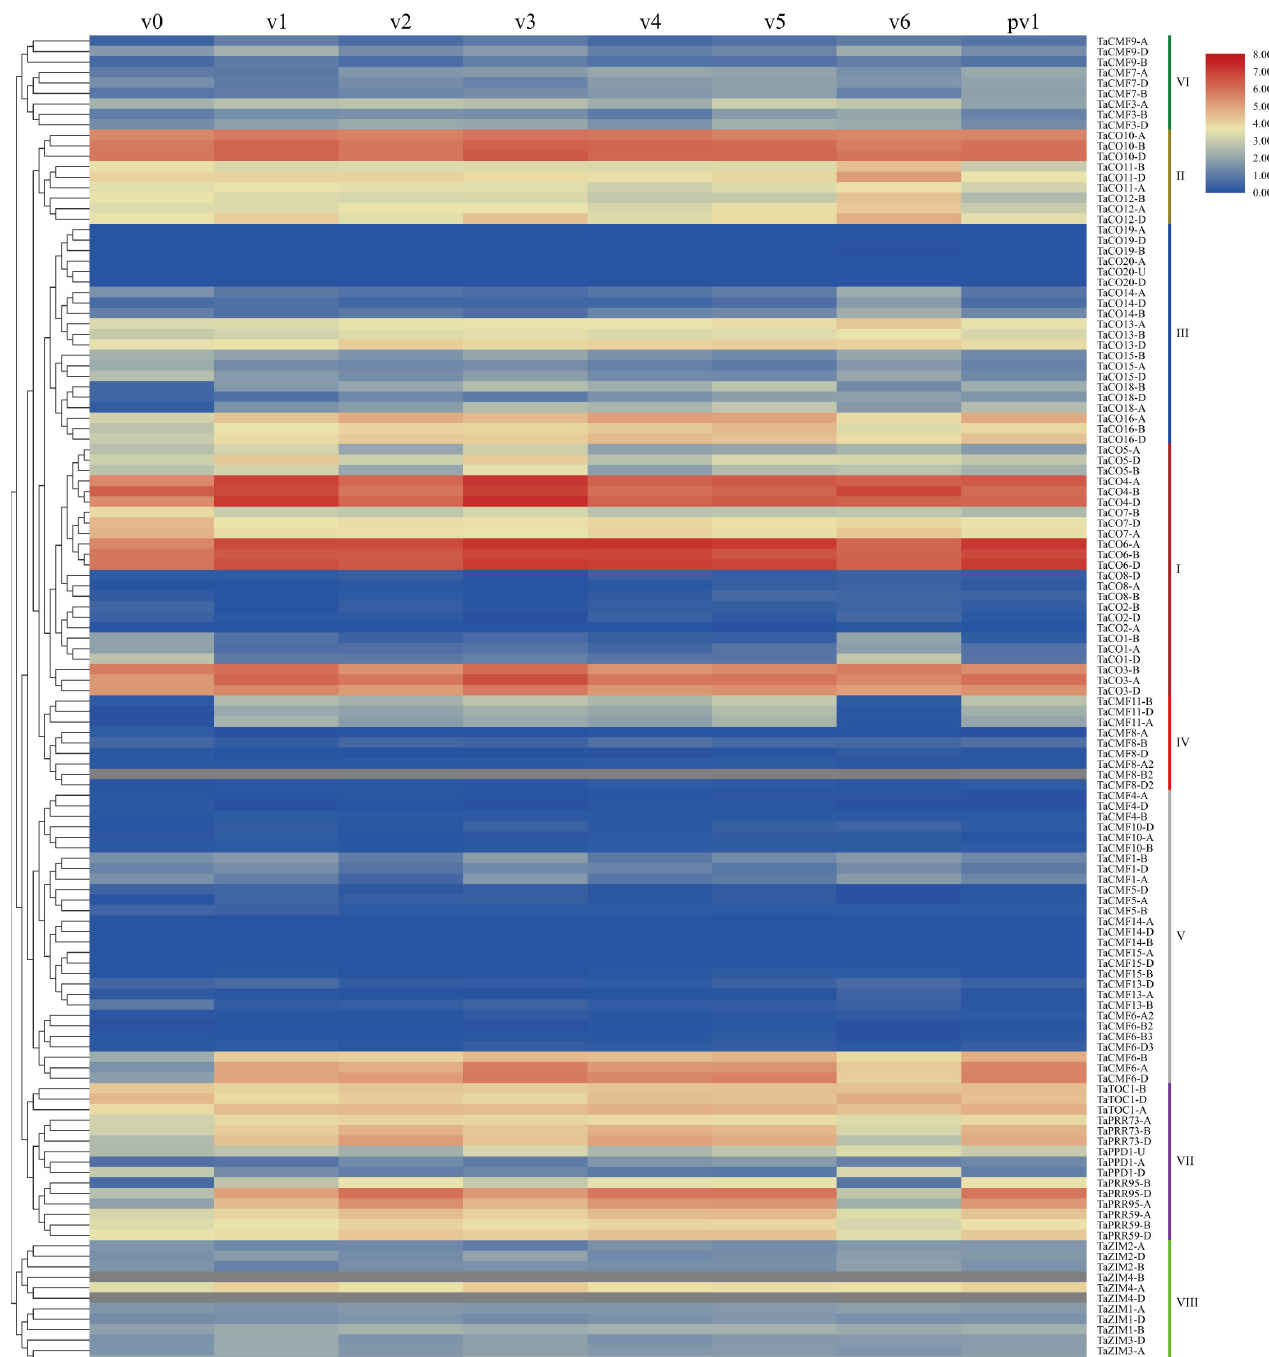
Fig 5. Expression profiling of CCT genes in wheat before, during, and after vernalization by RNA sequencing. The leaf samples were harvested before vernalization (v0), after one week’s vernalization (v1), two weeks’ vernalization (v2), three weeks’ vernalization (v3), four weeks’ vernalization (v4), five weeks’ vernalization (v5), six weeks’ vernalization (v6), and one-week normal growth after six weeks’ vernalization (pv1). The phylogenetic analysis that appeared here was the same as that in Fig 2.